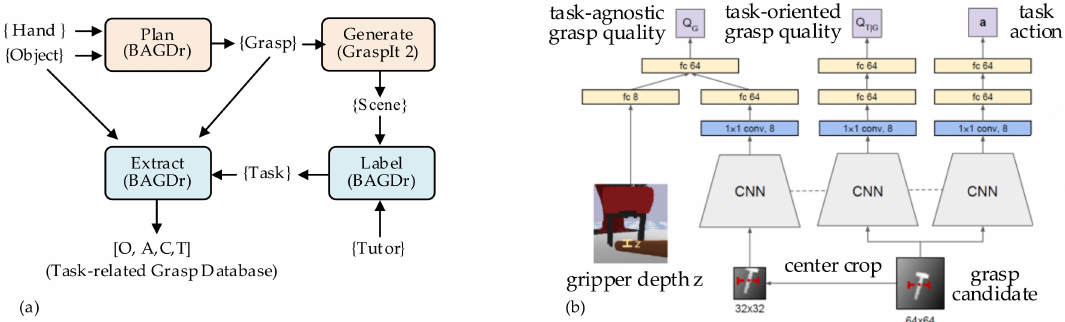
Figure 11. Examples of task oriented-based grasping approaches: ( a ) the schematic diagram for generating a task-related grasp database [86], ( b ) Task-Oriented Grasping Network